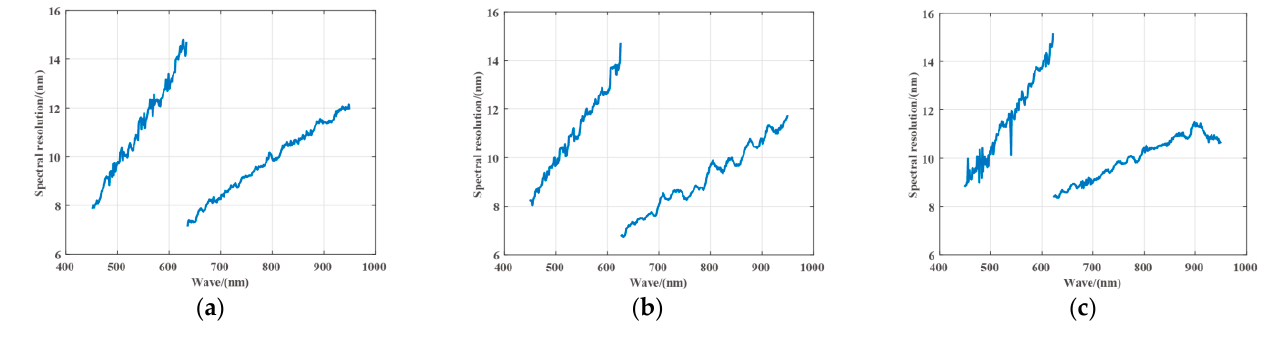
Figure 7. Spectral resolution of the camera. ( a ) CMOS 1; ( b ) CMOS 2; ( c ) CMOS 3.